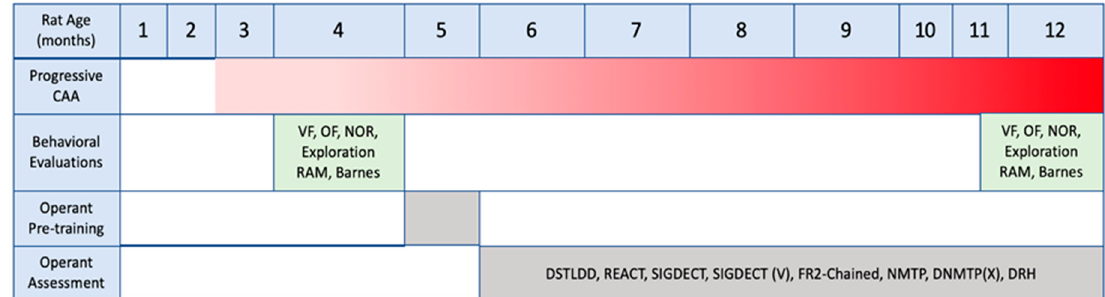
Figure 1. Overview of the study timeline. Rats began non-operant evaluation at ~3 months while pathology first emerged. Then, the rats were habituated to the operant chambers and core responding principles beginning at ~4 months, followed by detailed operant assessments from ~6 into 12 months while pathology continued progressing. Lastly, rats underwent a second round of non-operant evaluations beginning at ~10 months of age before euthanasia at ~12 months. See text for definitions.